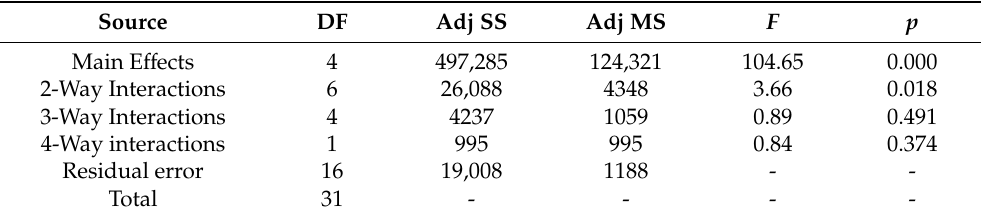
Table 3. Analysis of variance for medium size ( µ m).